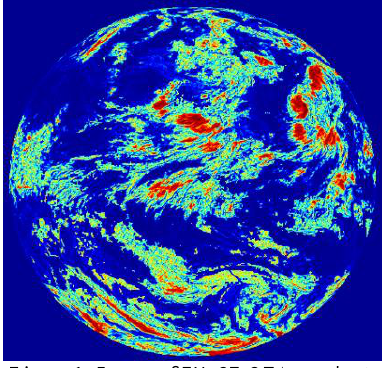
Figure 1. Image of FY-2E CTA products